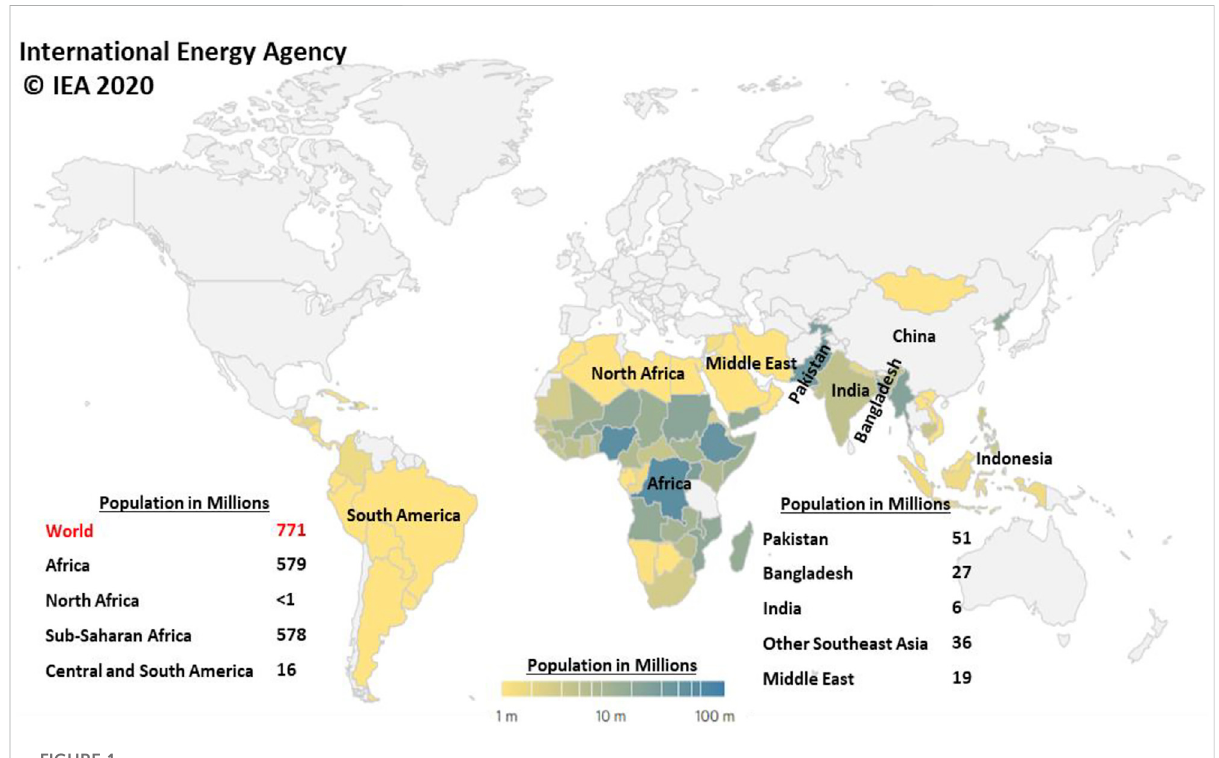
FIGURE 1 Region and population with lacking to